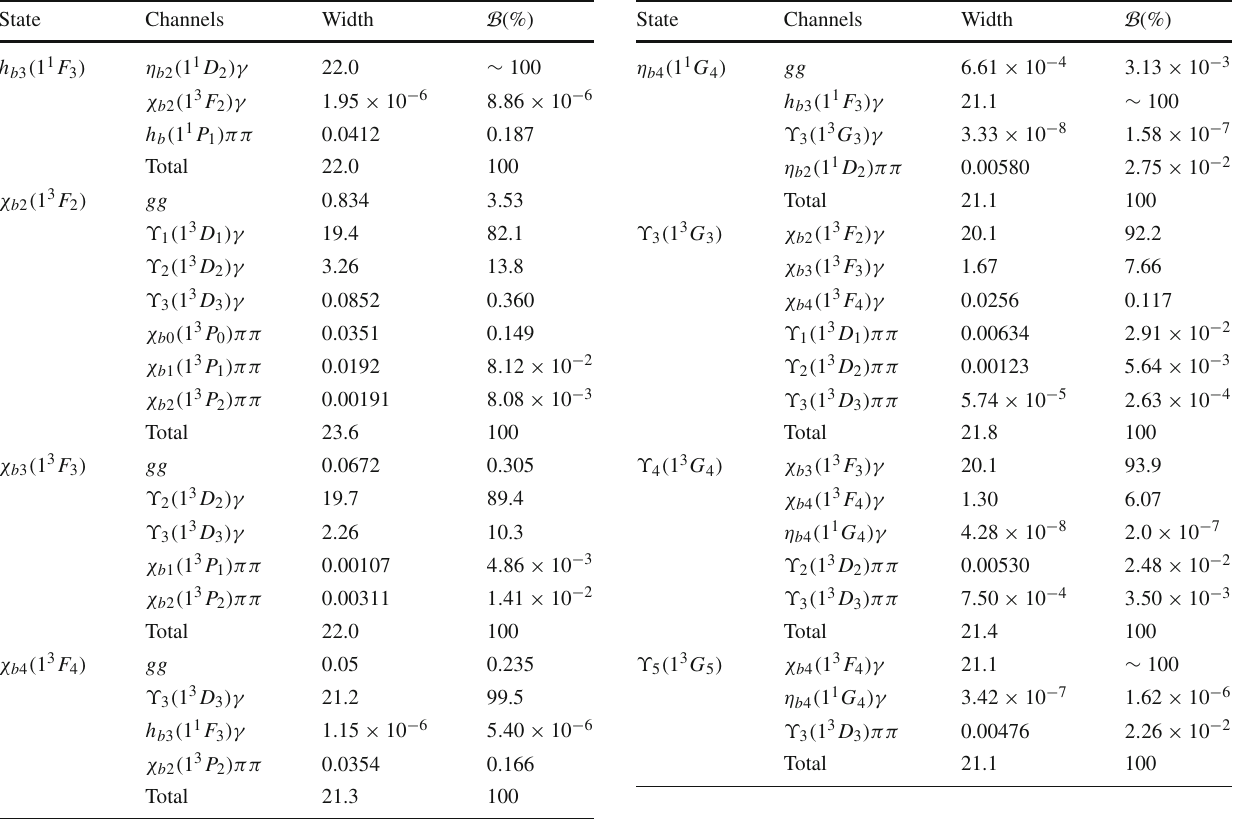
Table 13 Partial widths and branching ratios of annihilation decay, radiative transition, and hadronic transition and total widths for the 1 F bottomonium states. The widths are in units of keV